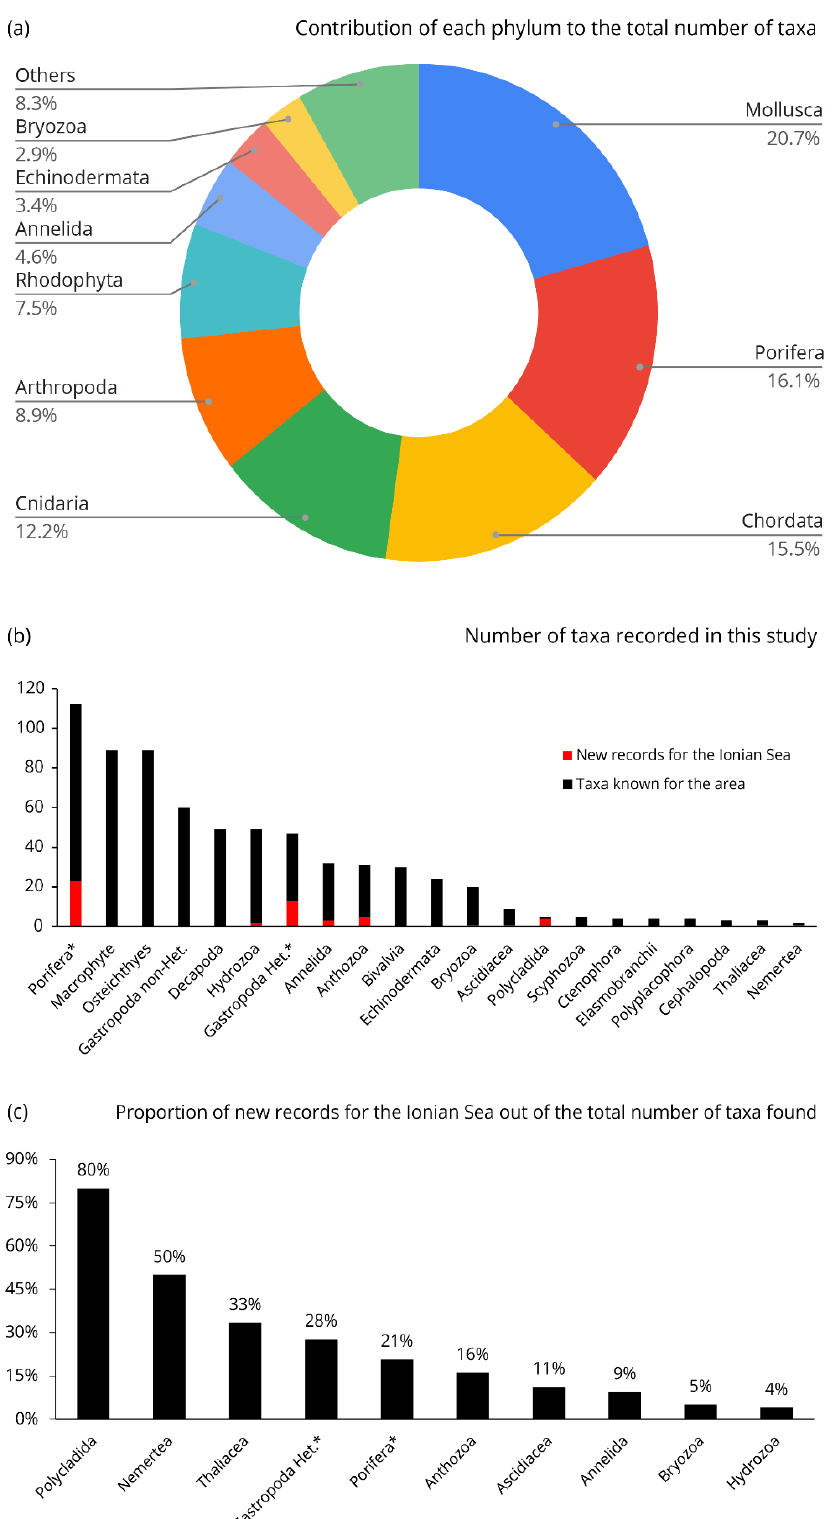
Figure 3. General description of the taxonomic composition and new records found by this study.